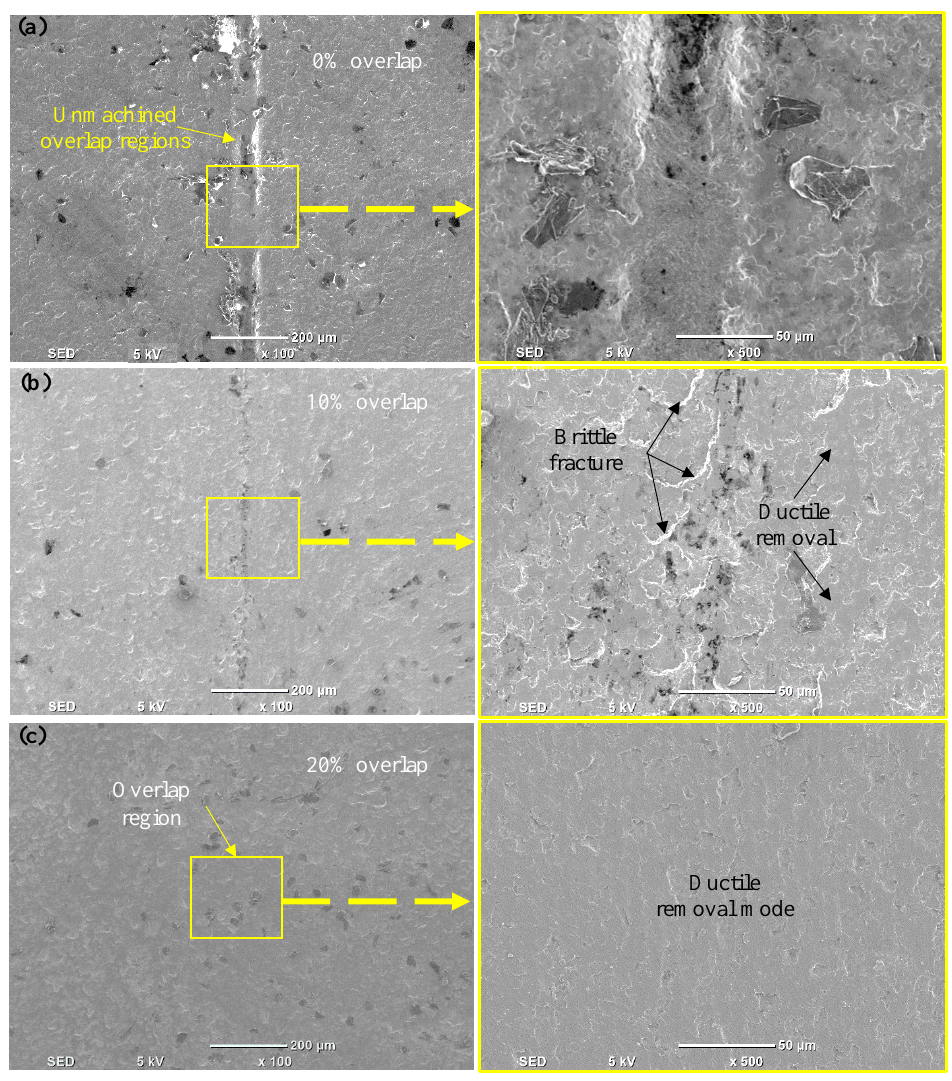
Figure 9. Pockets surface morphology machined at ( a ) 0% tool overlapping, ( b ) 10% tool overlapping and ( c ) 20% tool overlapping.